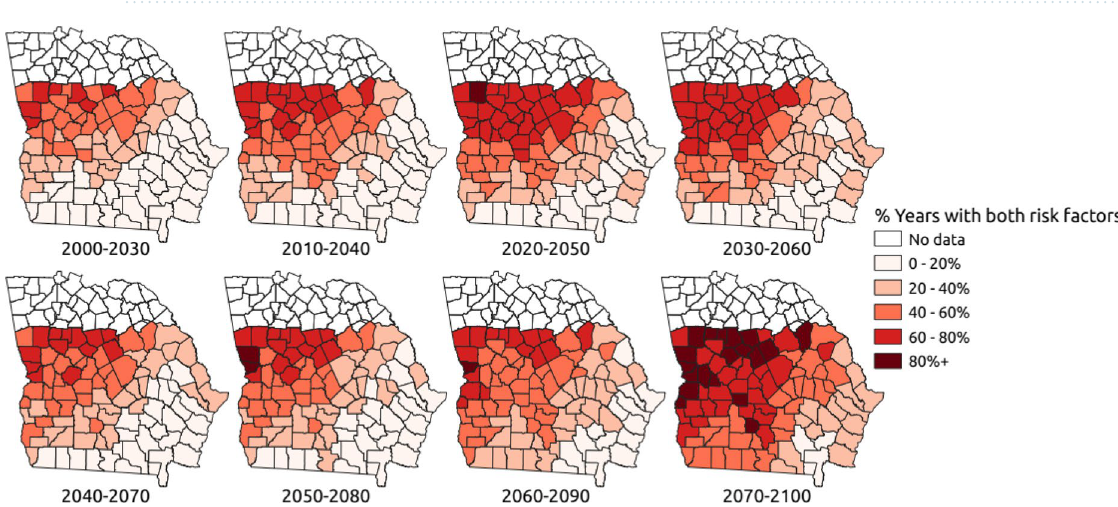
Figure 5. County maps of southern Georgia, USA, with the percentage of years predicted to exceed two weather risk factor thresholds assuming the RCP 8.5